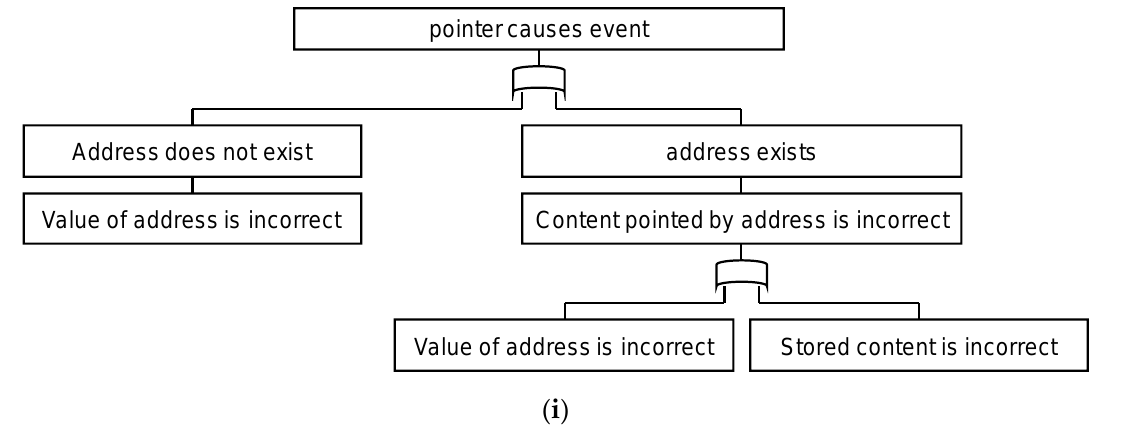
Figure 6. ( a ) Fault tree (FT) template for the Assigned Statement. ( b ) FT template for the If-Then-Else Statement. ( c ) FT template for the While Statement. ( d ) FT template for the Function Call. ( e ) FT template for the Interrupt. ( f ) FT template for the Global Variables. ( g ) FT template for the Local Variables. ( h ) FT template for the Array. ( i ) FT template for the Pointer.